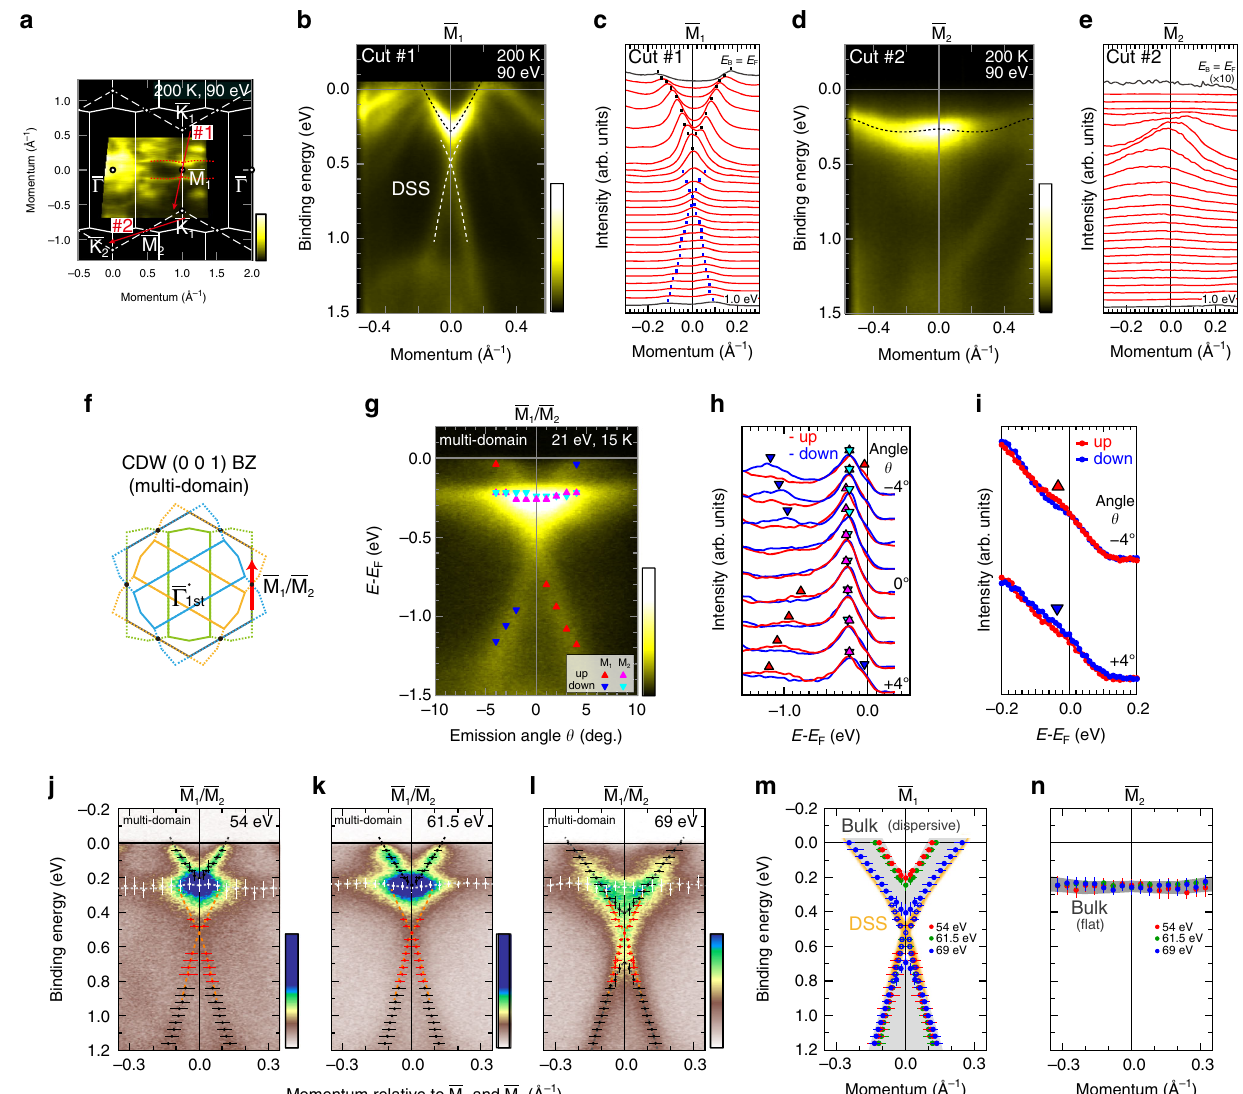
Fig. 5 Anisotropic electronic structures in the CDW 1 T ″ phase for VTe 2 . a Fermi surface image of single-domain VTe 2 (circular polarized 90 eV photons, 200 K). White broken lines and full lines indicate the 2D BZ in the 1 T and 1 T ″ phase, respectively. The red dotted curves denote the quasi-one-dimensional Fermi surface peculiar to the 1 T ″ phase. b ARPES image along cut #1 (as depicted in a ), nearly along (cid:1) K 1 (cid:1) (cid:1) M 1 (cid:1) (cid:1) K 1 direction. The black and white dotted curves respectively trace the dispersive bulk band and the Dirac surface state similar to 1 T . c MDCs for b , ranging from E B = 0 to 1.0 eV (integral width: 0.02 eV). The black (blue) makers represent the MDC peak positions for the dispersive bulk band (Dirac surface state). d , ARPES image along cut #2, nearly along (cid:1) K 1 (cid:1) (cid:1) M 2 (cid:1) (cid:1) K 2 . The black dotted curve traces the fl at band peculiar to 1 T ″ . e MDCs for d . The MDC at E F is multiplied by 10. f Schematic 2D BZ with mixed in-plane CDW domains. The red arrow qualitatively follows the measurement direction of spin-resolved and h ν -dependent ARPES. g ARPES image with the peak plots of spin-resolved spectra ( s polarized 21 eV photons, 15 K). The domains are not separated. Red (blue) triangle markers indicate the peak positions of spin-up (-down) spectra of (cid:1) M 1 side bands, whereas purple (cyan) for (cid:1) M 2 side. h Spin-resolved spectra around (cid:1) M 1 = (cid:1) M 2 points. i Spin- resolved spectra near E F at θ = ±4 ◦ . j – l h ν -dependent ARPES images of a multi-domain sample recorded with 54 eV ( j ), 61.5 eV ( k ), and 69 eV ( l ) photons ( s polarization, 15 K). Circles markers with vertical (horizontal) error bars represent the peak positions of EDCs (MDCs). The black and red markers are respectively assigned to the dispersive bulk band and the Dirac surface state at (cid:1) M 1 side, while the white markers correspond to the fl at bulk state at (cid:1) M 2 side. m Schematic band dispersion along (cid:1) K 1 (cid:1) (cid:1) M 1 (cid:1) (cid:1) K 1 with experimental band plots. The orange curve represents the schematic of the Dirac surface state, whereas the blurred gray curves are those for the bulk bands. n Same as m , but along (cid:1) K 1 (cid:1) (cid:1) M 2 (cid:1) (cid:1) K 2 (cid:1) (cid:1) (cid:1) (cid:1) M (cid:1) (cid:1) K observed at the M the schematic band dispersions along K and side. With this we can conclude that the 1 1 1 1 (cid:1) (cid:1) (cid:1) (cid:1) M (cid:1) (cid:1) K , overlaid with the experimental peak plots side has unusually localized nature, K electronic state at the M 1 2 2 2 (cid:1) which should give rise to the dissolution of the band inversion side, the V-shaped band with extracted from Fig. 5j – l. At the M 1 along k z direction. high intensity clearly shows the fi nite k z -dispersion of >0.2 eV, together with the h ν -independent Dirac surface state. These are (cid:1) (cid:1) (cid:1) similar to the case of normal 1 T phase along K (cid:1) M (cid:1) K (Fig. 4k). Picture of CDW state based on orbital bonding . To grasp the (cid:1) side, the emergent fl at band shows On the other hand, at the M essential feature of the CDW state, here we introduce the local 2 negligible k z -dependence, in contrast to the V-shaped band orbital picture. For simplicity, we adopt an orthogonal octahedral